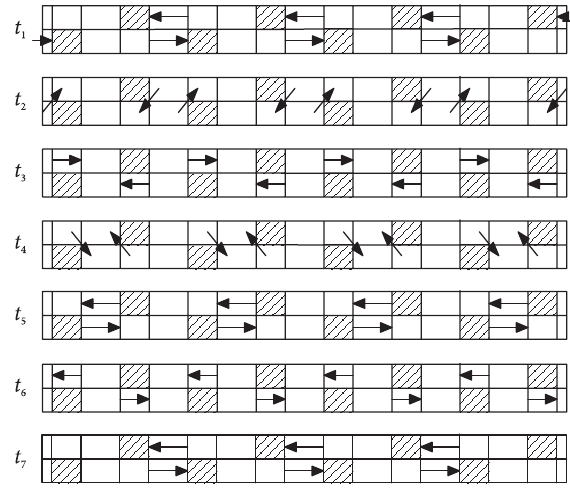
Fig. 4. Time diagrams of vehicle packs traveling in a bi- directional “green wave” mode on a two-lane highway during construction works time period